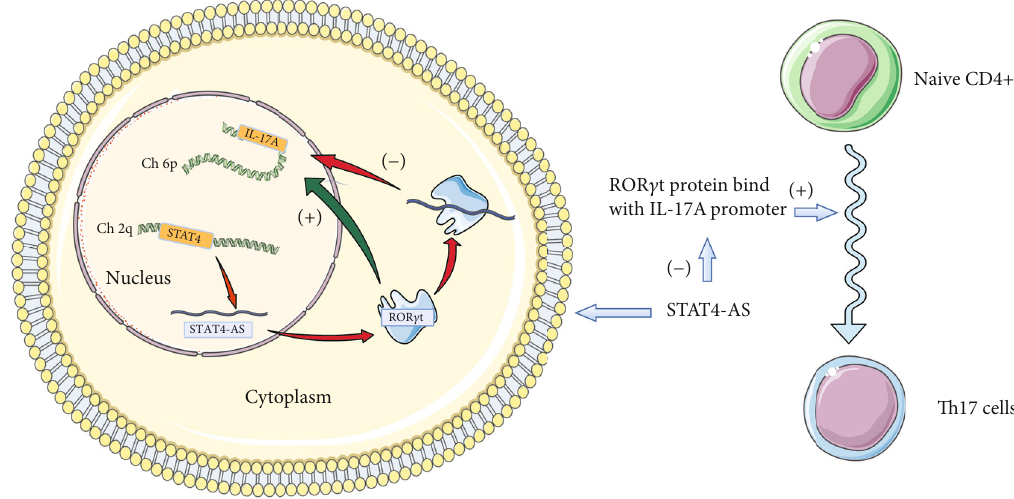
Figure 7: The mechanism of lncRNA STAT4-AS1 on TH17 di ff